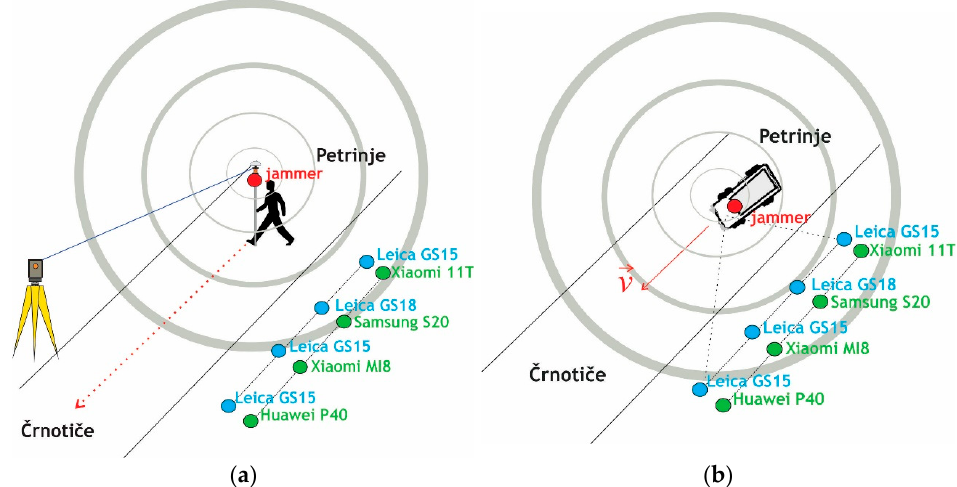
Figure 6 . ( a ) the walking experiment, in which the jammer was attached to the pole directly under the prism and the position of the jammer was determined by TPS; and ( b ) the driving experiment, in which the jammer was placed in the vehicle.